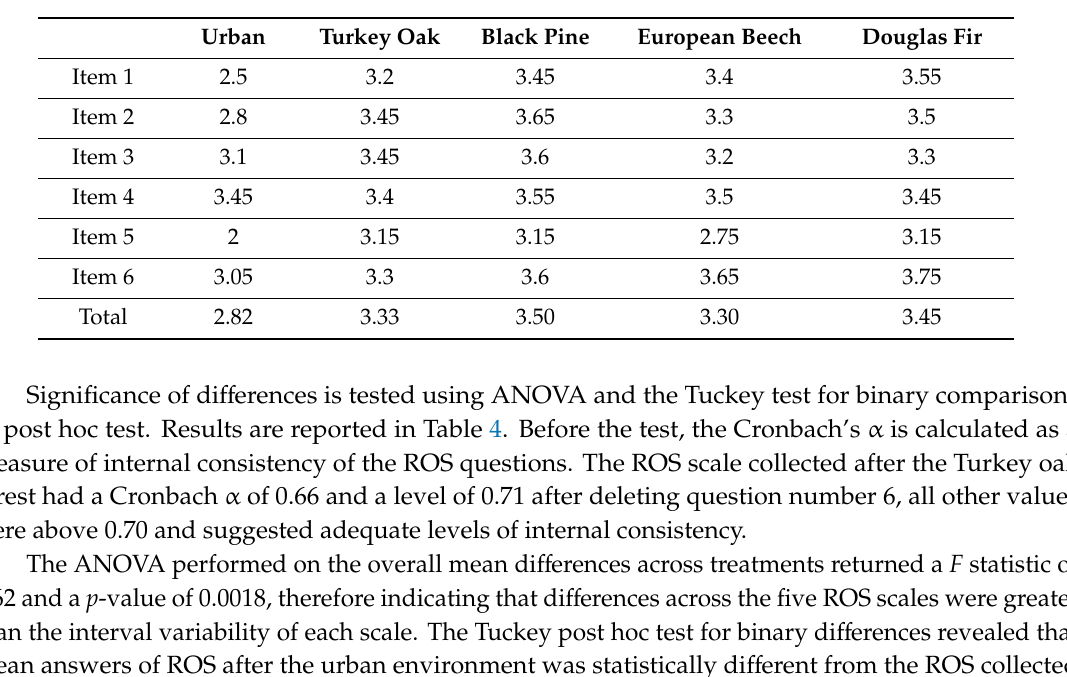
Table 3. Mean answers to Restoration Outcome (ROS) items after each EEG